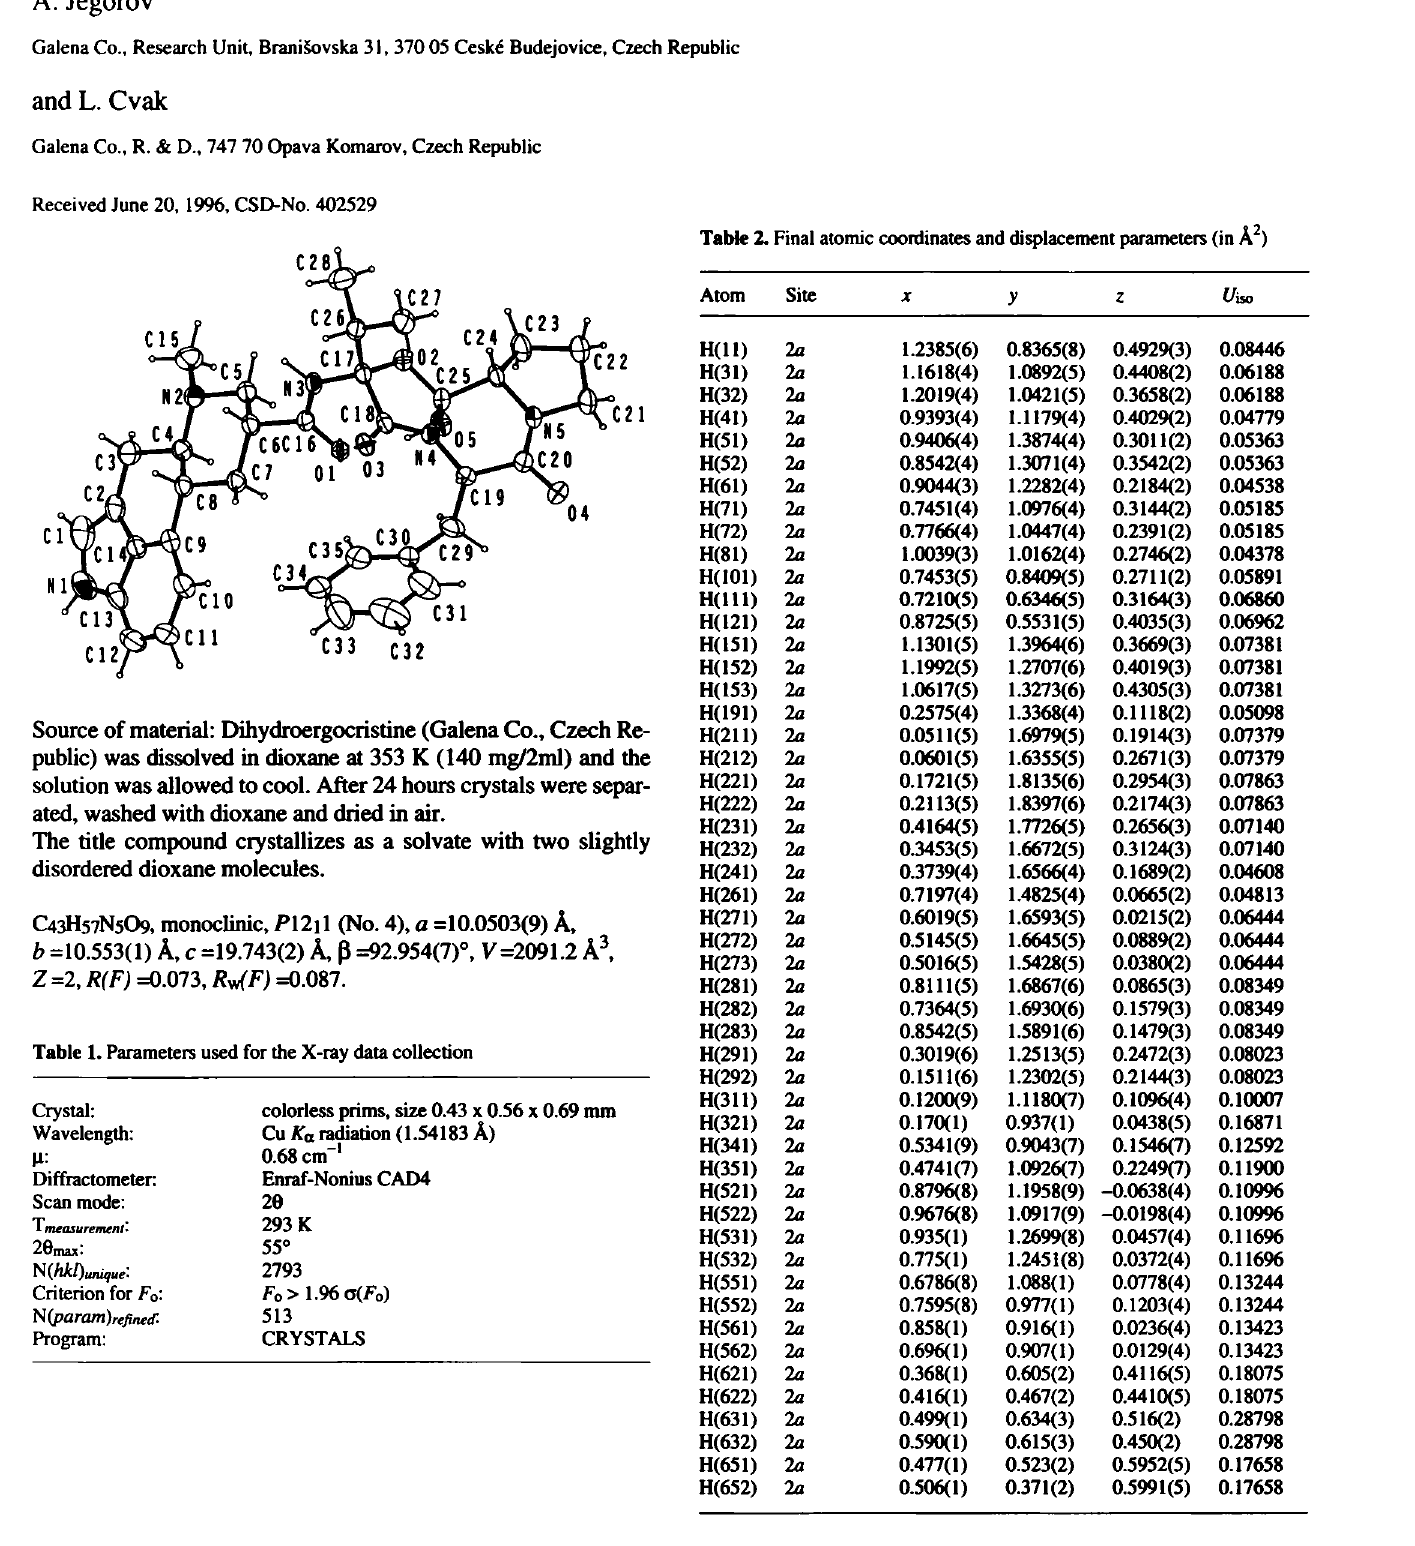
Table 2. Final atomic coordinates and displacement parameters (in Â 2